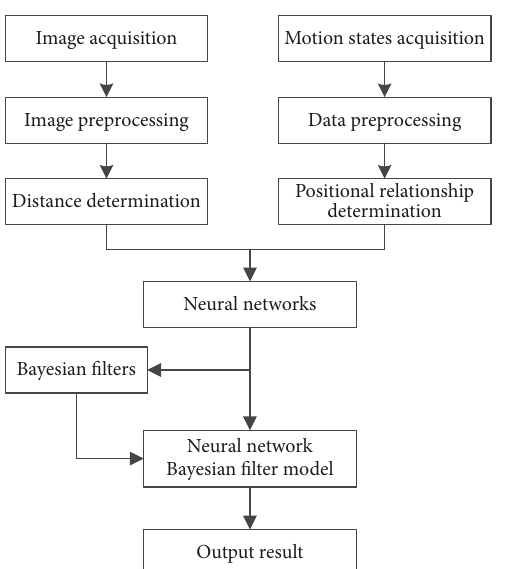
Figure 2: Flow chart of risky driving behavior identification.